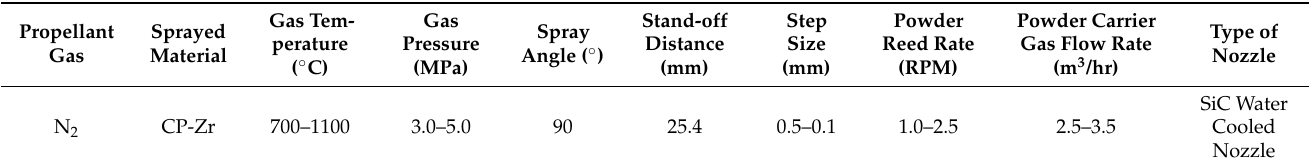
Table 1. Processing parameters of CS